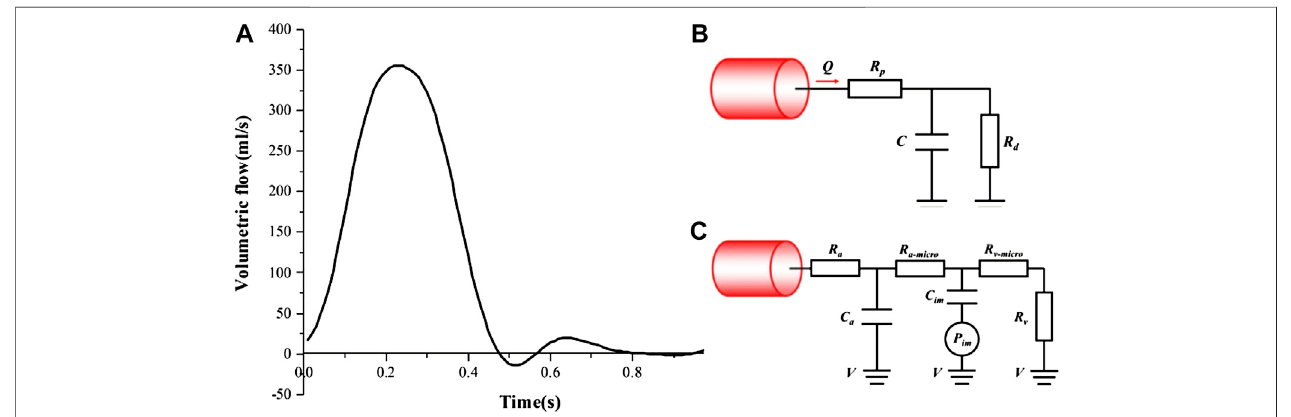
the capacitance was set to 0.001 cm 5 /dyne. The outlet of the fi stula was set to “ wall ” to represent the occlusion. All the walls were assumed to be rigid with no slip conditions.